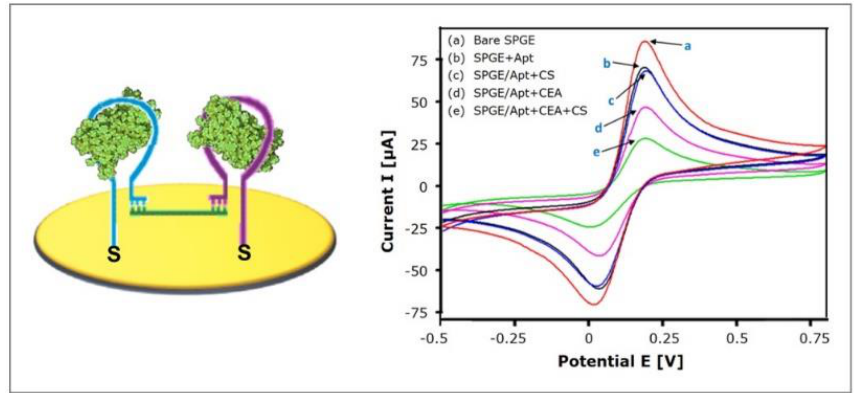
Figure 11. Target-induced bridge assembly: ( A ) Schematic representation of the aptasensor; ( B ) Impact on cyclic voltammetry, adapted with permission from the authors of [94], copyright 2018, John Wiley & Sons.